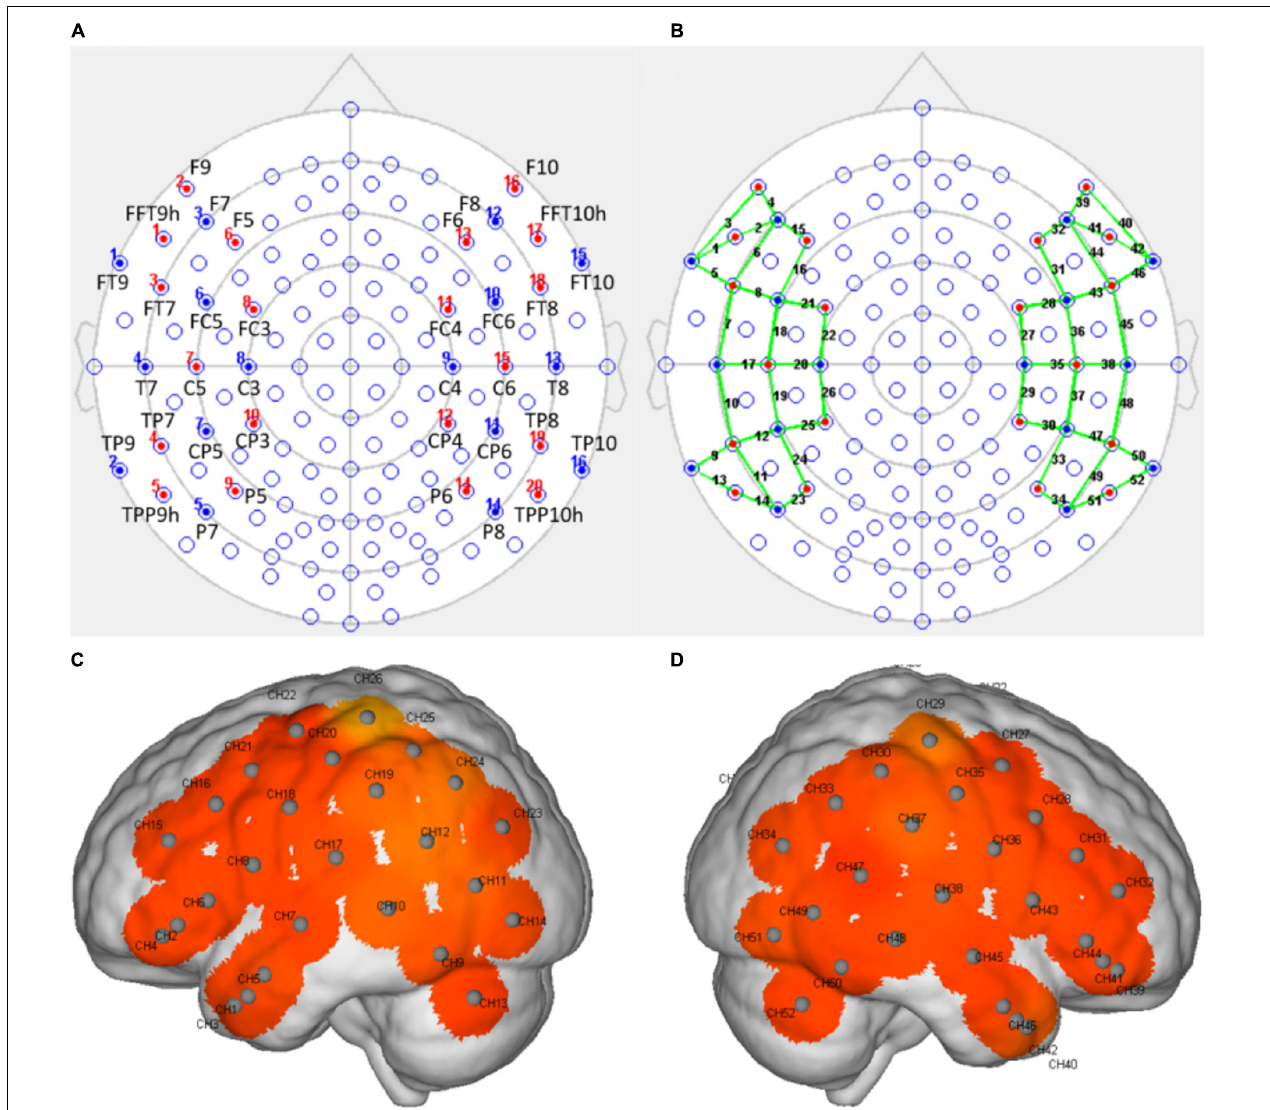
FIGURE 2 | The arrangement of the light sources and detectors and the positions of the detection channels. (A) The position of the light sources and detectors, arranged according to the 10–20 system, with red indicating a light source and blue indicating a detector. (B) A schematic representation of the positions of the detection channels (indicated by the green line) formed by the light sources and the detectors. (C,D) Schematic representations of the channel positions in the left (C) and right (D) hemispheres during fNIRS. Each gray dot represents the center of the detection